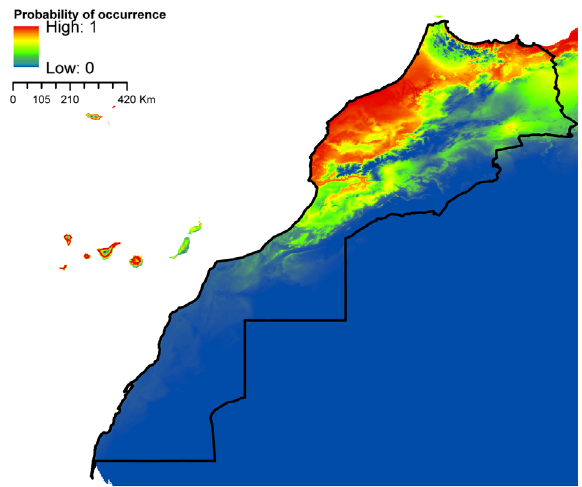
Figure 4. Predicted distribution of Ae. caspius in